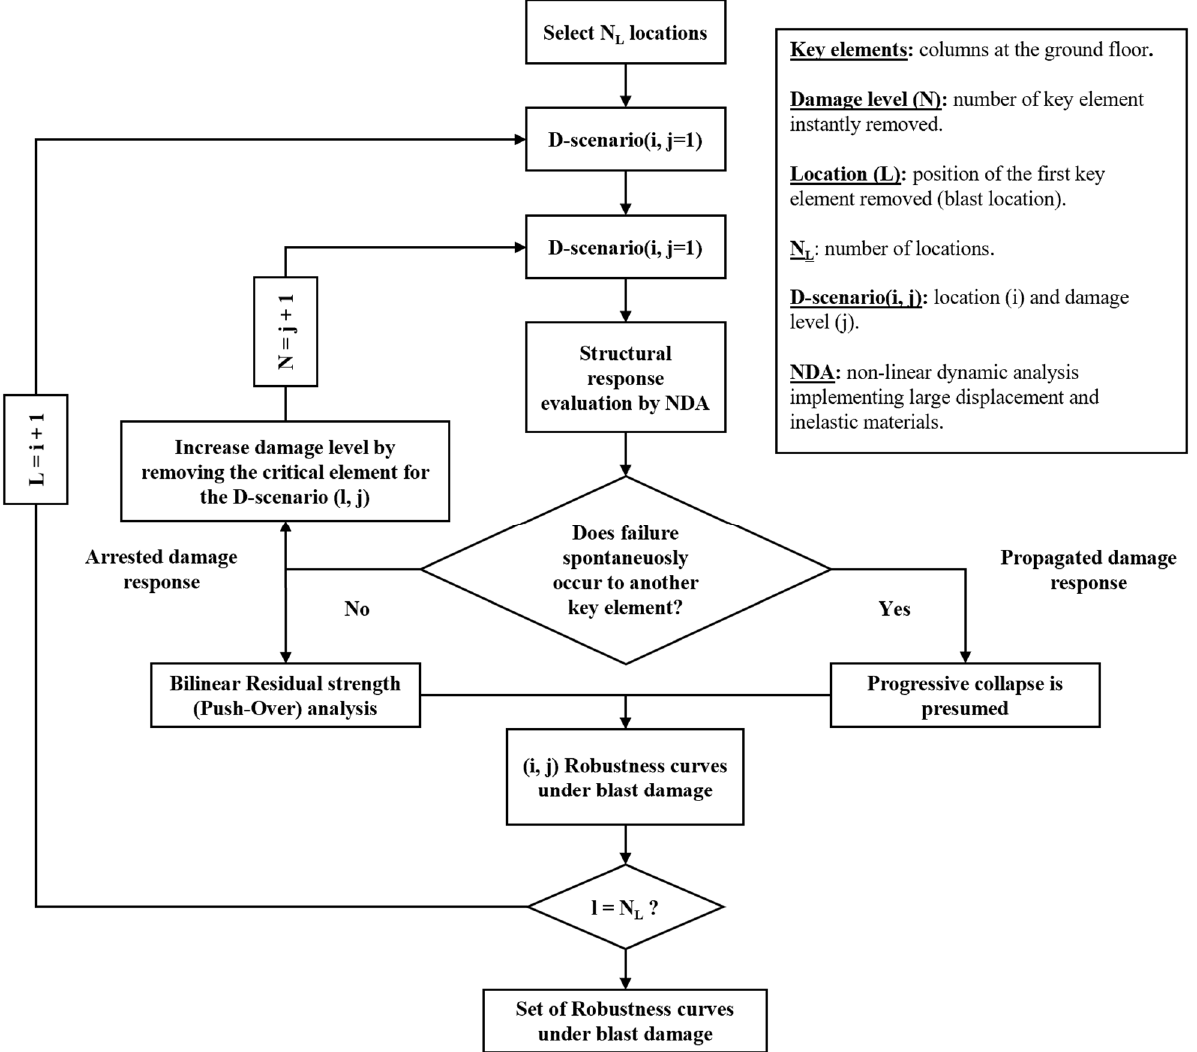
Figure 2. Flowchart of the procedure to evaluate the structural robustness against blast damage [17].